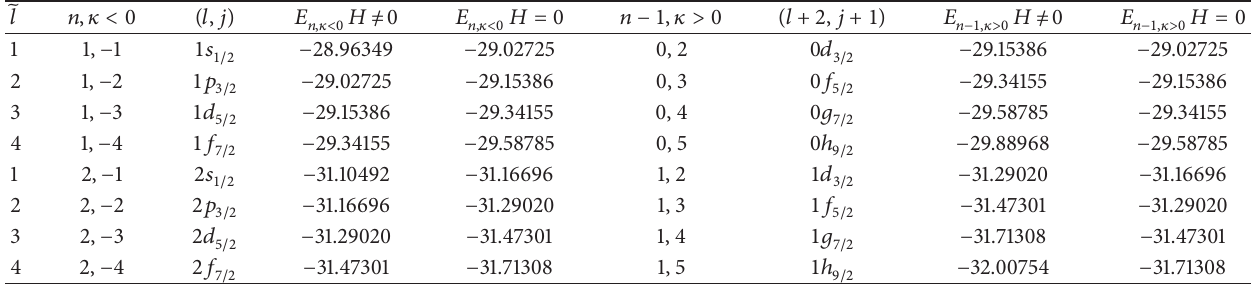
Table 4: The bound state energy eigenvalues in units of fm − 1 of the p -spin symmetry tPT potential for several values of 𝑛 and 𝜅 with 𝛼 = 0.8 .